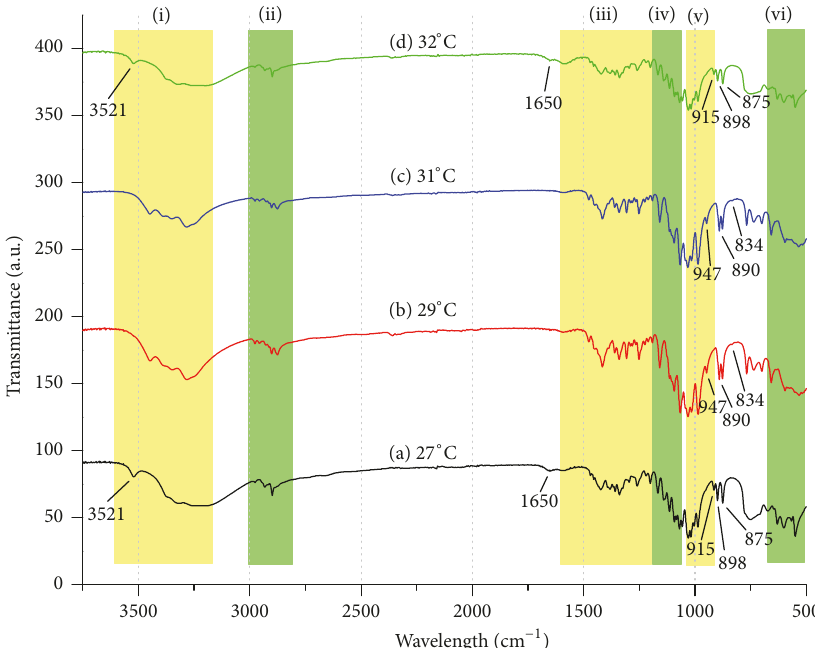
Figure 2: FTIR spectra of samples prepared at different temperatures. Temperature is indicated on each